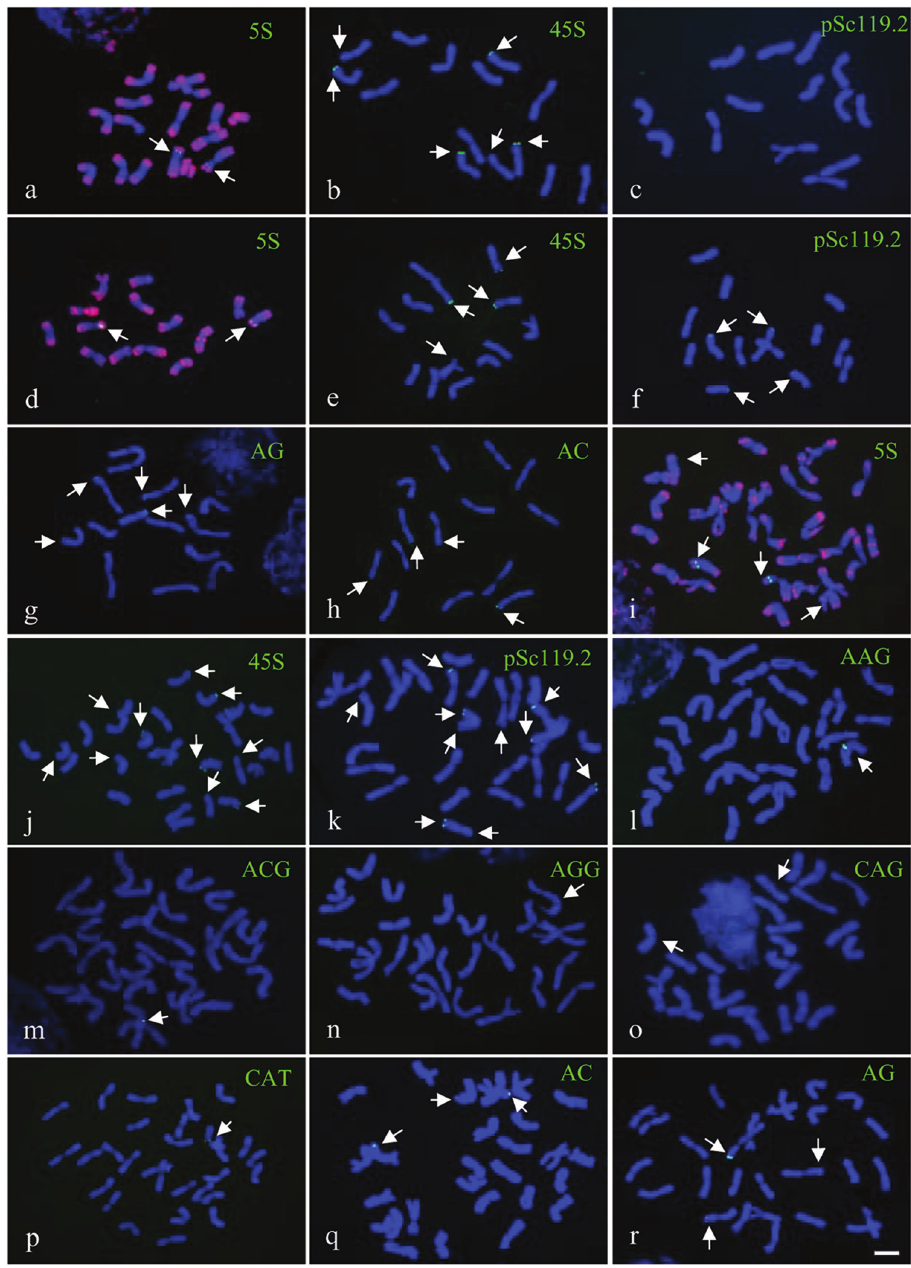
Figure 1. FISH patterns of mitotic metaphase chromosomes detected using pAs1 probes (red) com- bined with 5S rDNA, 45S rDNA, and pSc119.2 probes in A. mongolicum ( a–c ); 5S rDNA, 45S rDNA, pSc119.2, AG, and AC in A. cristatum (2x) ( d–h ); 5S rDNA, 45S rDNA, pSc119.2, AAG, ACG, AGG, CAG, CAT, AG, and AC in A. cristatum (4x) ( i–r ). The pAs1 signals (red) were removed artificially in all images except in ( a, d, i ). Arrows indicate the target signals (green). Bar =